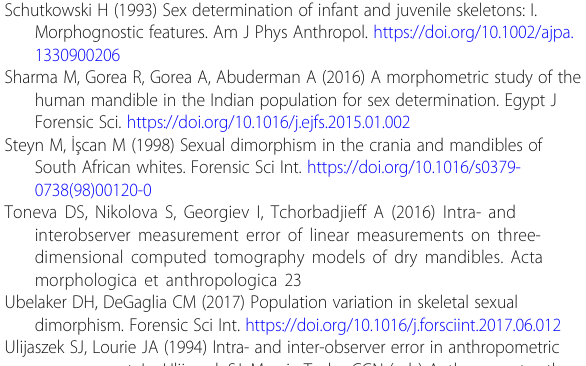
Schutkowski H (1993) Sex determination of infant and juvenile skeletons: I. Morphognostic features. Am J Phys Anthropol. https://doi.org/10.1002/ajpa. 1330900206 Sharma M, Gorea R, Gorea A, Abuderman A (2016) A morphometric study of the human mandible in the Indian population for sex determination. Egypt J Forensic Sci. https://doi.org/10.1016/j.ejfs.2015.01.002 Steyn M, İş can M (1998) Sexual dimorphism in the crania and mandibles of South African whites. Forensic Sci Int. https://doi.org/10.1016/s0379- 0738(98)00120-0 Toneva DS, Nikolova S, Georgiev I, Tchorbadjieff A (2016) Intra- and interobserver measurement error of linear measurements on three- dimensional computed tomography models of dry mandibles. Acta morphologica et anthropologica 23 Ubelaker DH, DeGaglia CM (2017) Population variation in skeletal sexual dimorphism. Forensic Sci Int. https://doi.org/10.1016/j.forsciint.2017.06.012 Ulijaszek SJ, Lourie JA (1994) Intra- and inter-observer error in anthropometric measurement. In: Ulijaszek SJ, Mascie-Taylor CGN (eds) Anthropometry: the individual and the population. University Press,